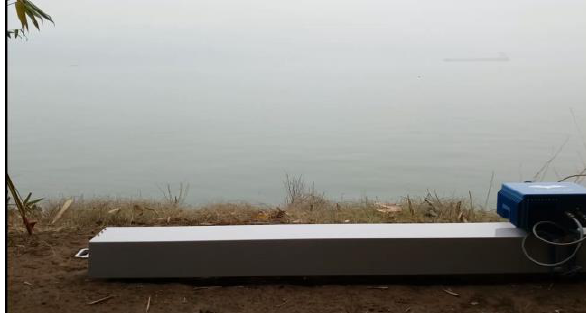
Figure 2. The experimental environment